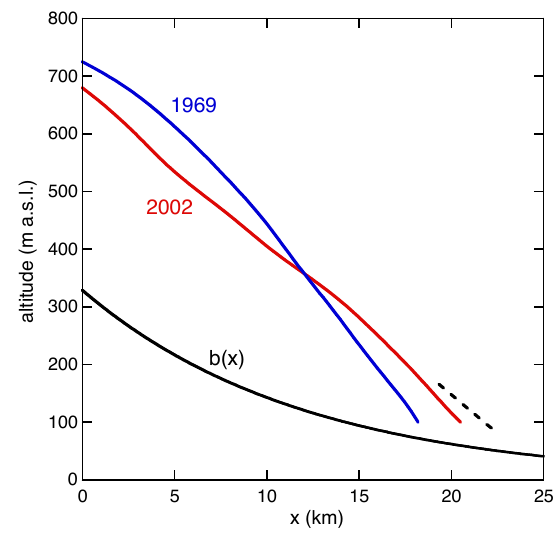
Figure 4. Altitude profiles along the central flow line of Abra- hamsenbreen derived from topographic maps. The surge took place Fig. 4 . Altitude profiles along the central flowline of Abrahamsenbreen derived from 3 around 1978. The dashed line indicates a possible maximum exten- topographic maps. The surge took place around 1978. The dashed line indicates a possible 4 sion of the glacier immediately after the surge. The reference bed profile is shown as b(x) maximum extension of the glacier immediately after the surge. The reference bed profile is 5 shown as b ( x ). 6